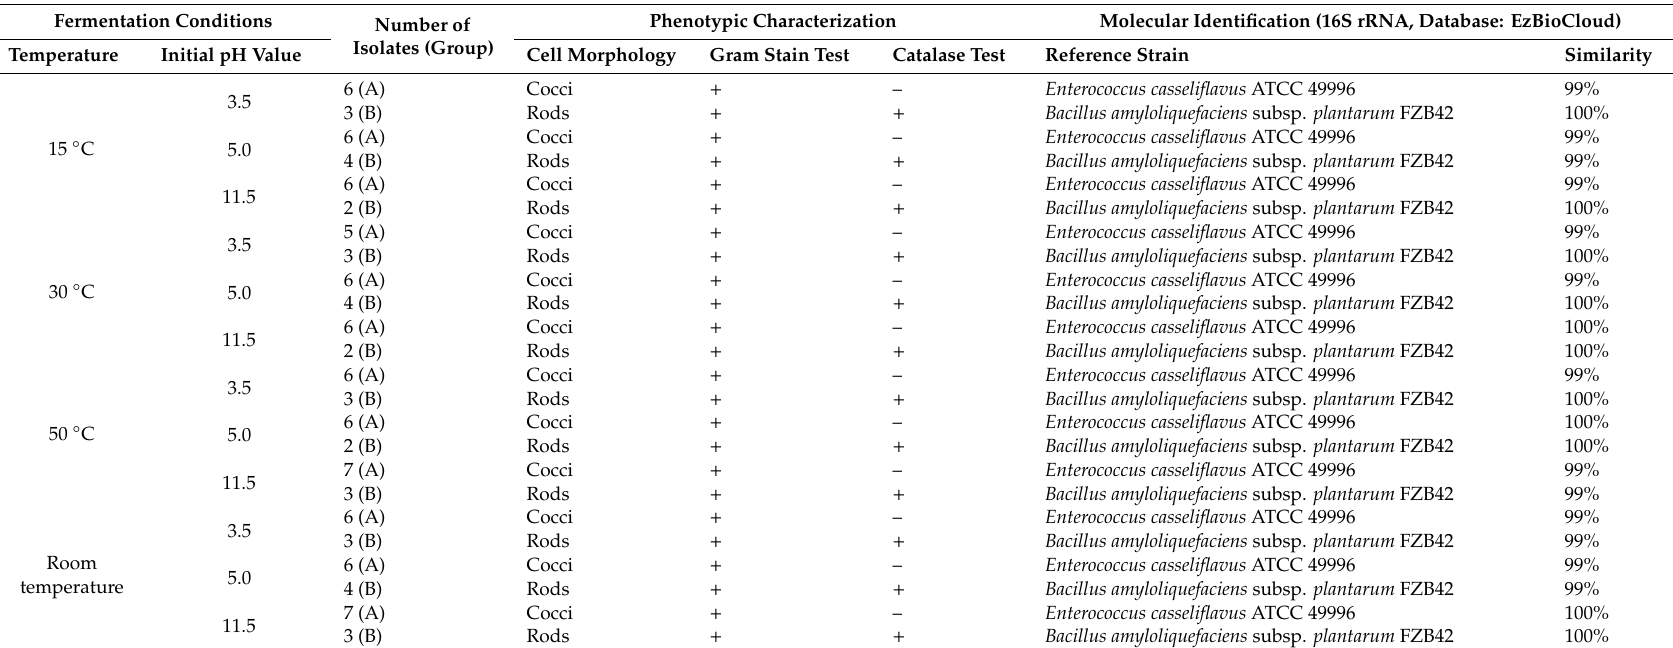
Table 2. Phenotypic characterization and molecular identification of the isolated strains from fermented Spanish-style green olive processing wastewaters under di ff erent temperature and initial pH